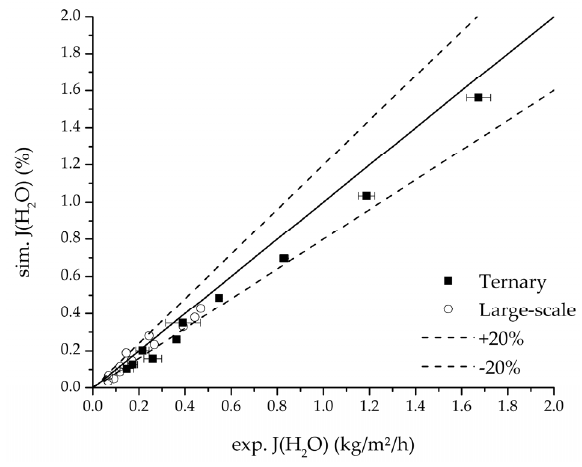
Figure 24. Parity plot between the experimental and simulated water flux for the ternary system at 95 °C feed temperature.